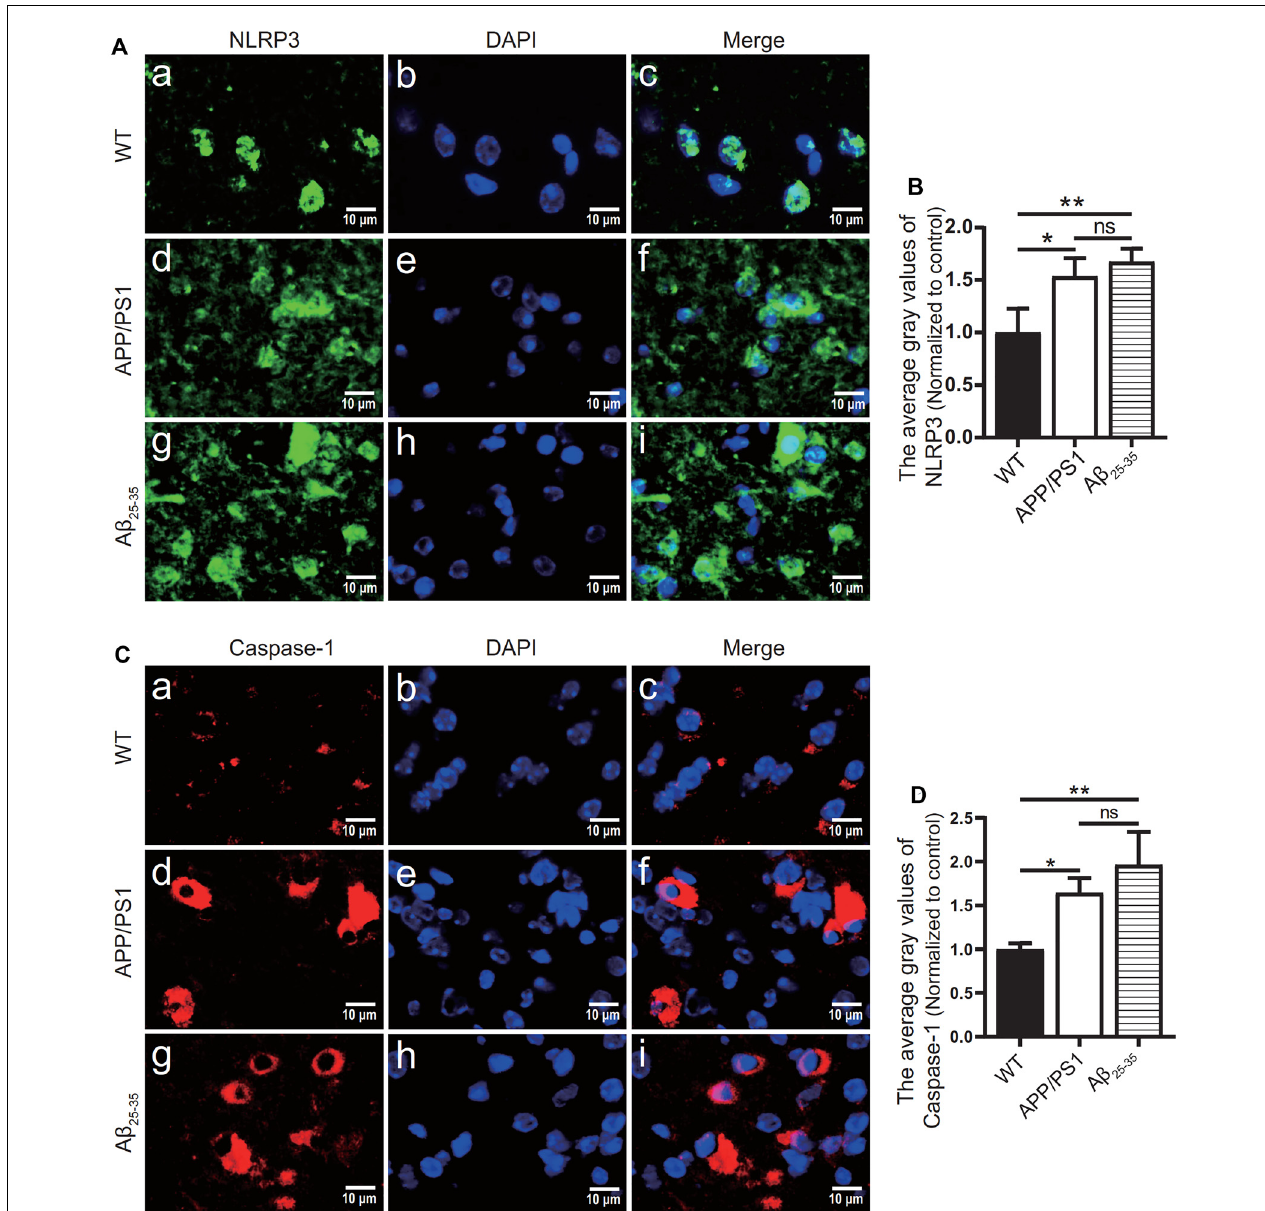
FIGURE 2 | NLRP3 inflammasome-related proteins were increased in AD model mice. (A,C) Immunofluorescence was used to analyze the expression of the NLRP3 inflammasome-related proteins NLRP3 and caspase-1 in the brain tissues of the WT group, APP/PS1 group, and A β 25–35 group mice. (B,D) The difference in fluorescence intensity between groups was compared (* p < 0.05, ** p < 0.01; “ns” means there is no significant difference; n =